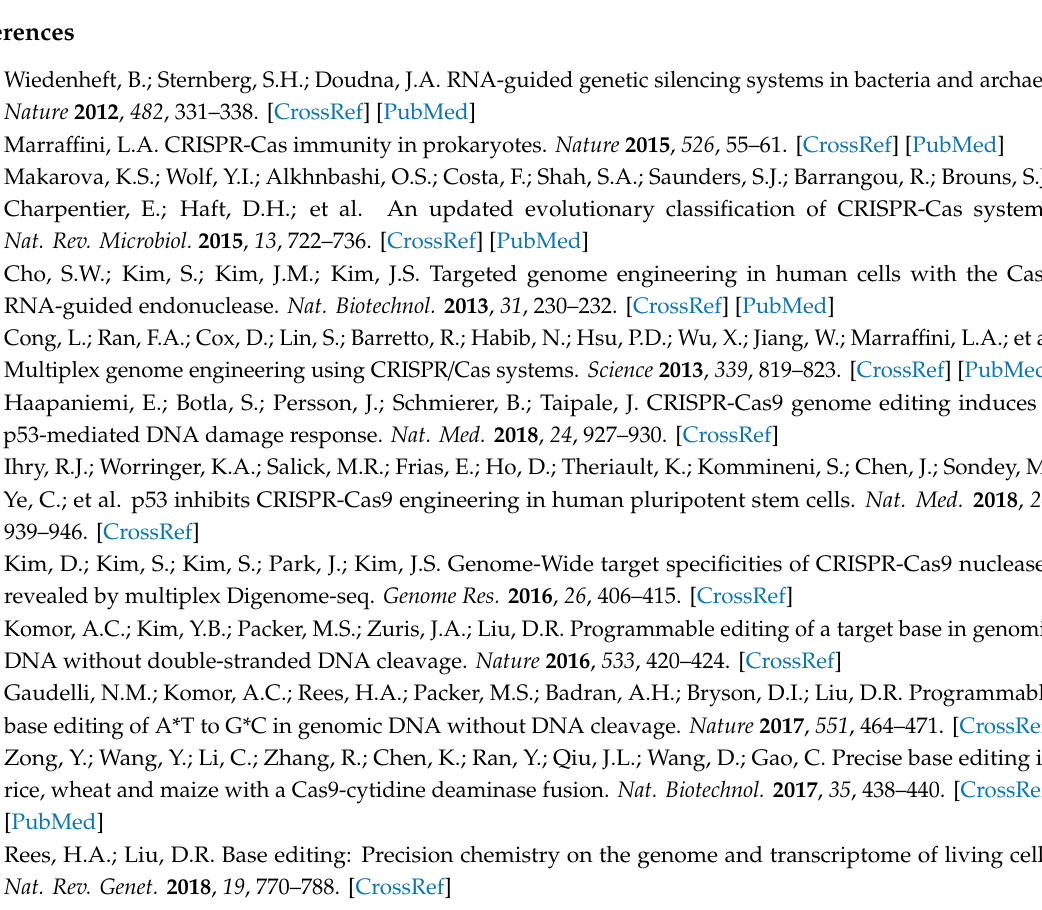
Figure S1–S28: Supplementary Figures, Table S1–S4: Supplementary